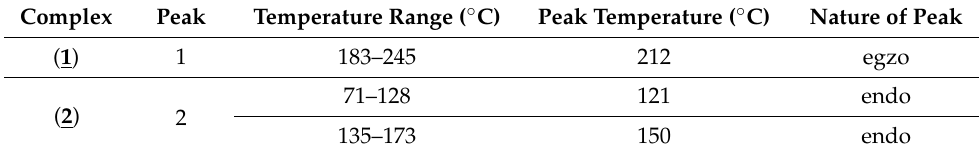
Table 11. DSC data of the two